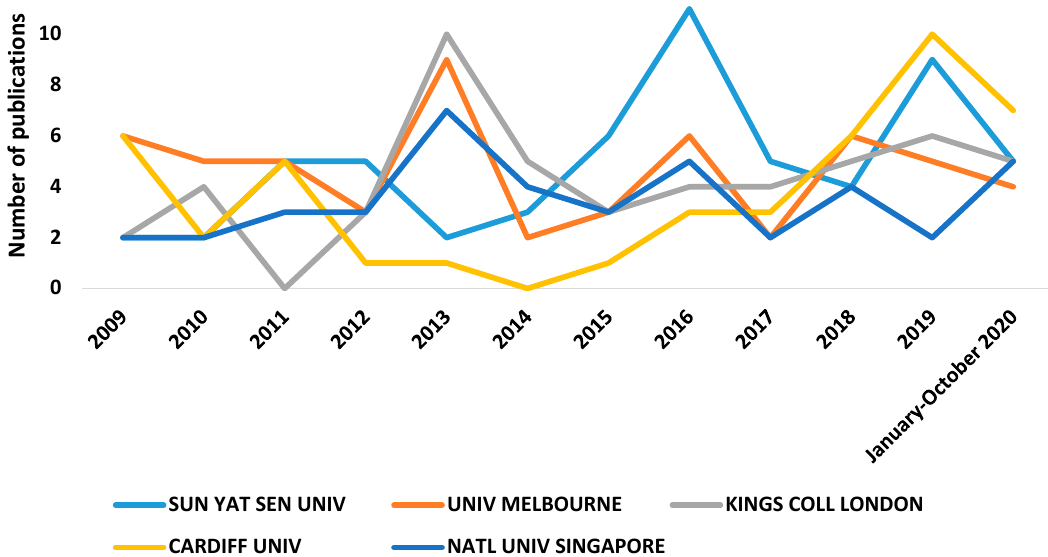
Figure 4. Number of publications per institutions and year.